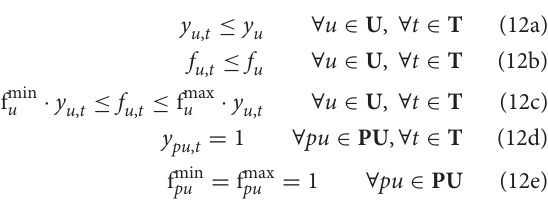
), and Equations (12d) and , f max u u